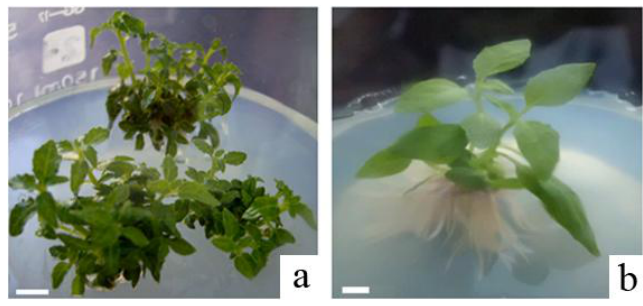
Figure 1. High-frequency plant regeneration of Populus davidiana Dode × Populus bollena Lauche. ( a ) Regenerated shoots from leaf explants; ( b ) Regenerated plantlet. Scale bar 1 cm.